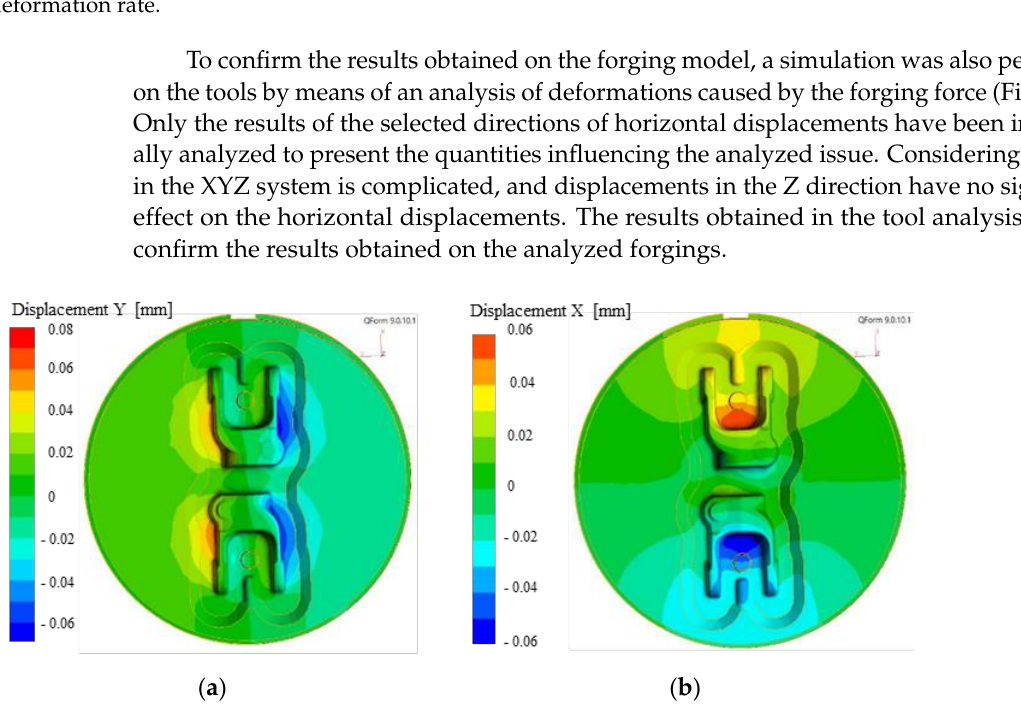
Figure 13. Results of numerical modelling: ( a ) material flow rate during roughing, ( b ) material flow rate in the transverse direction, ( c ) deformation rate.